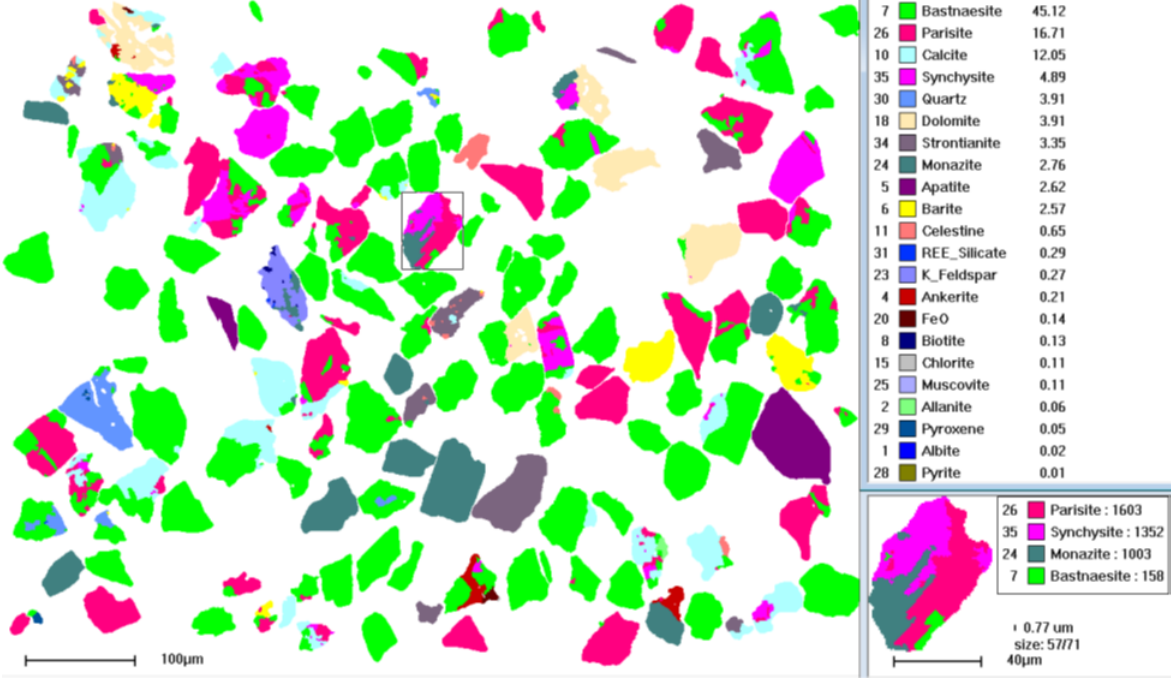
Figure 5. False-color image from MLA of the MPC material. Values represent surface area percentages.